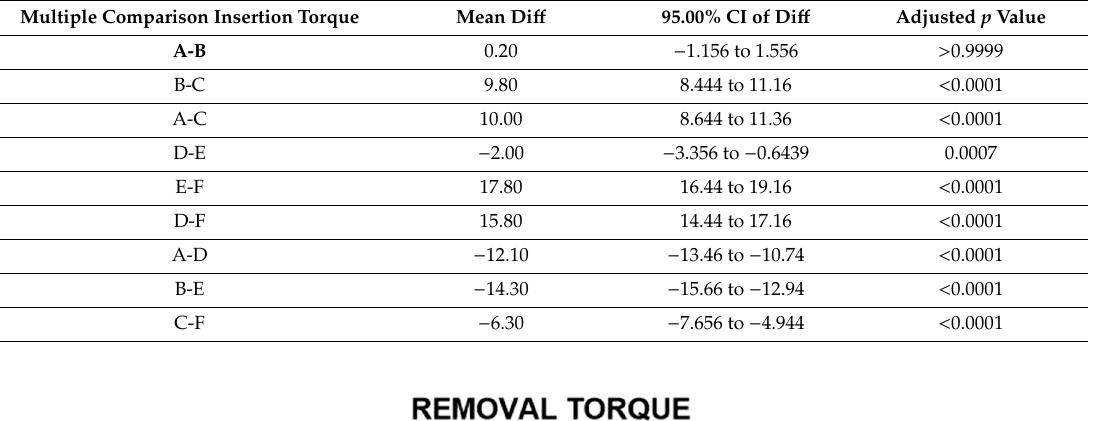
Table 2. Insertion torque ANOVA Bonferroni post hoc groups comparison.